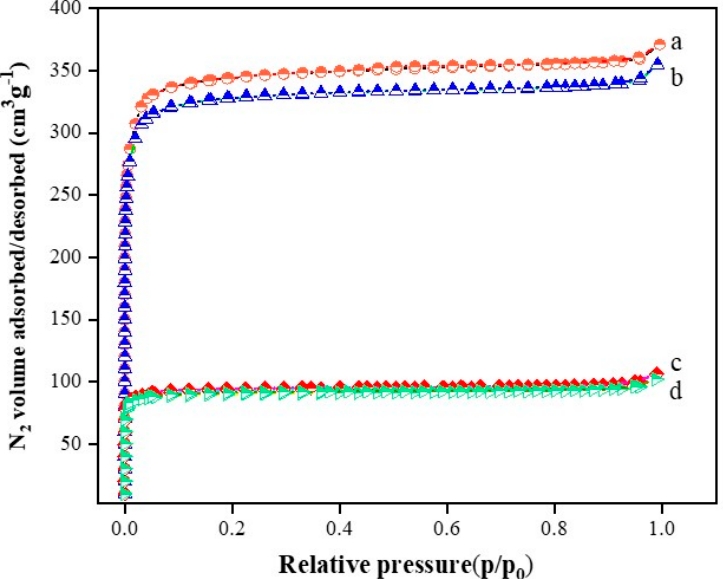
Figure 1. N 2 adsorption/desorption analysis of ( a ) 0.1% Pd@U ( b ) 0.2% Pd@U ( c ) 1% Pd@U ( d ) 2% Pd@U.